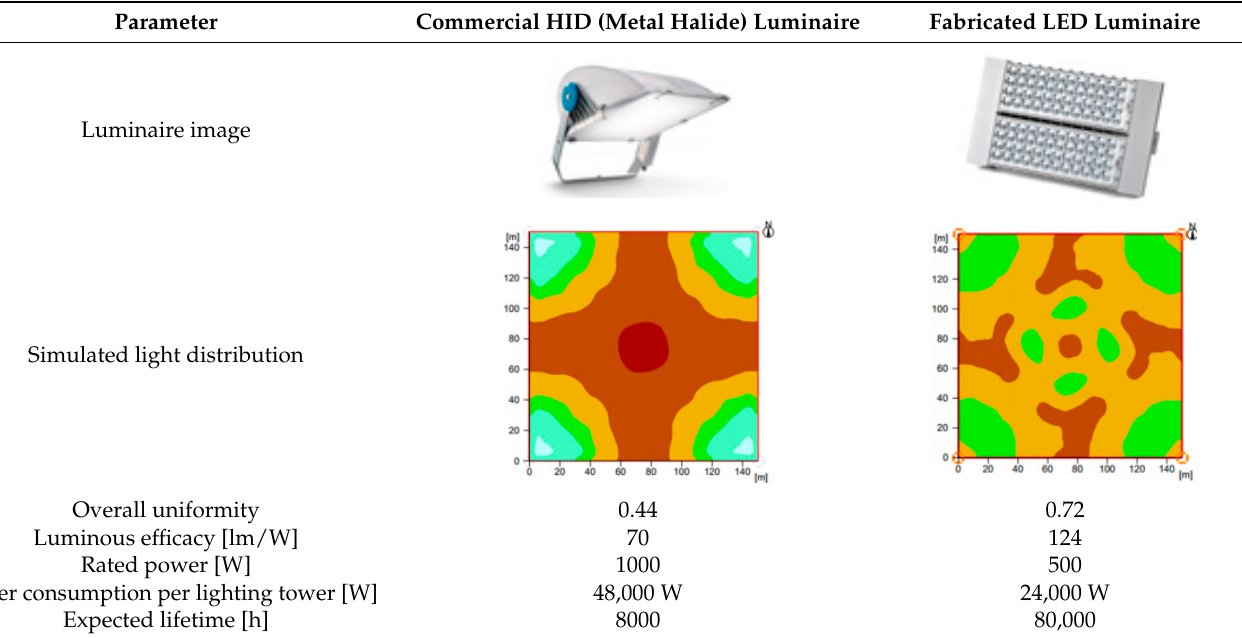
Table 7. Characteristics of LED and HID luminaires for seaport lighting application. Parameter Commercial HID (Metal Halide) Luminaire Fabricated LED